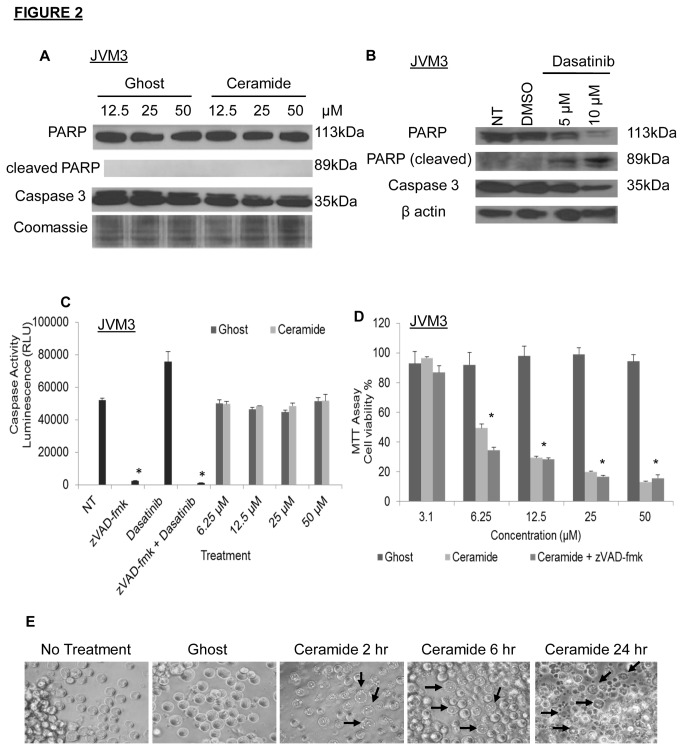
Cell death induced by nanoliposomal C6-ceramide occurs through caspase 3/7-independent necrosis.JVM3 cells were treated with A). different doses of ghost and C6-ceramide nanoliposome for 24 hours, B) 5 µM and 10 µM dasatinib, as well as DMSO vehicle control for 24 hours, then Western Blot analysis was performed for caspase 3 and PARP cleavage. C). Enzymatic activities of caspase 3/7 were measured using caspase 3/7 luminescence kit. * P < 0.05. D). JVM3 cells were treated with varying doses of ghost or C6-ceramide nanoliposomes for 24 hours following a 2 hour pre-treatment or no pre-treatment with zVAD-fmk (15 µM). Cell viability was assessed via MTT assay. * P < 0.05. E). JVM3 cells were treated with 25 µM ghost nanoliposomes for 24 hours or C6-ceramide nanoliposomes for 2, 6 and 24 hours and phase contrast microscopy images were taken. Arrows indicate morphology of necrotic cell death.